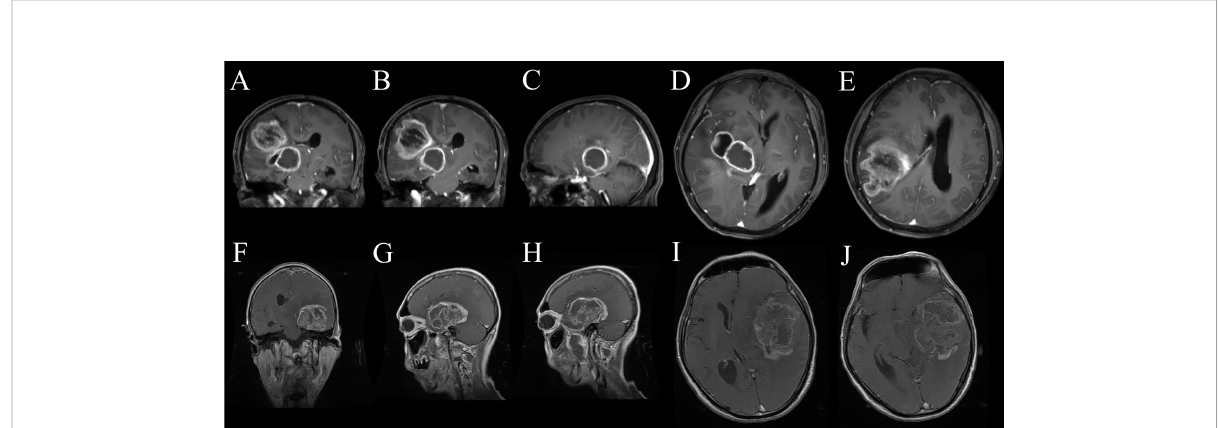
appearances (A) , multiple lobes (B) , regular shape (C) , uniform thickness of ring (D) and small diameter of ring (E) . The patient with WT BRAF showed the opposite images such as single ring enhancement appearances (F) , single lobes (G) , irregular shape (H) , nonuniform thickness of ring (I) and relatively larger diameter of ring (J) .